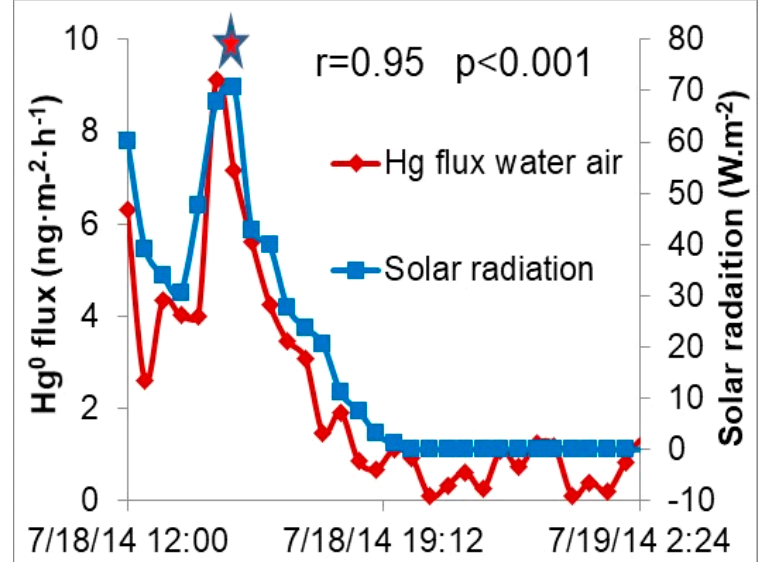
Figure 4. Gaseous elemental mercury (GEM) emissions from the pond were highly correlated with solar radiation, with the greatest flux at maximum solar radiation (star).